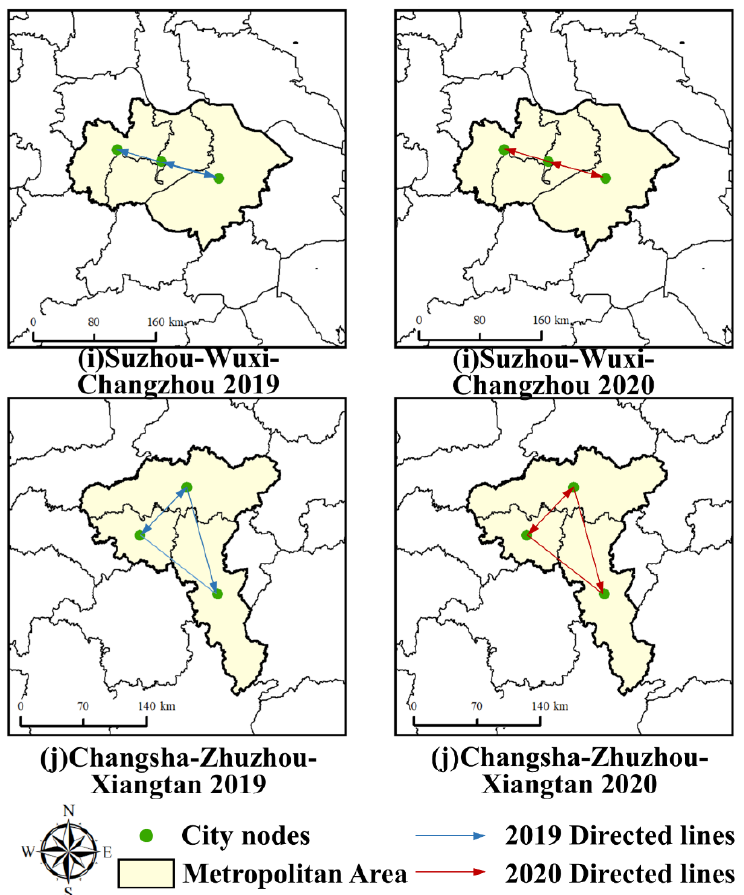
Figure 3. PM 2.5 spatial correlation networks in ten metropolitan areas from 2019 to 2020 (arrows indicate relationships between the two cities).